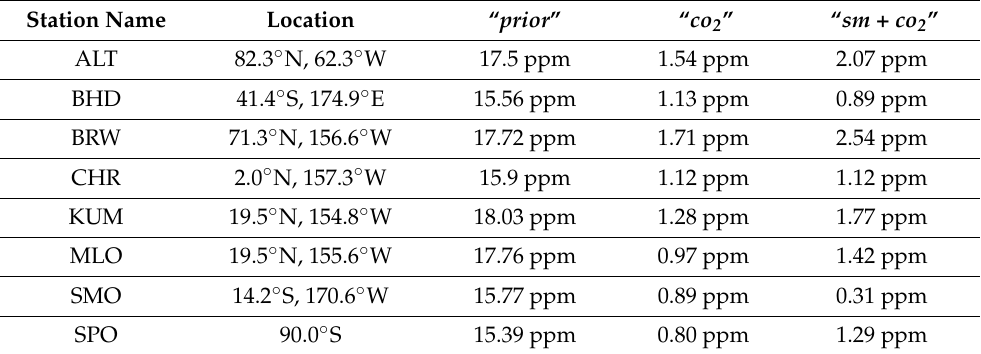
Table 1. The RMSEs for “ prior ”, “ co 2 ”, and “ sm + co 2 ” experiments with respect to SIO CO 2 concen- tration observations,